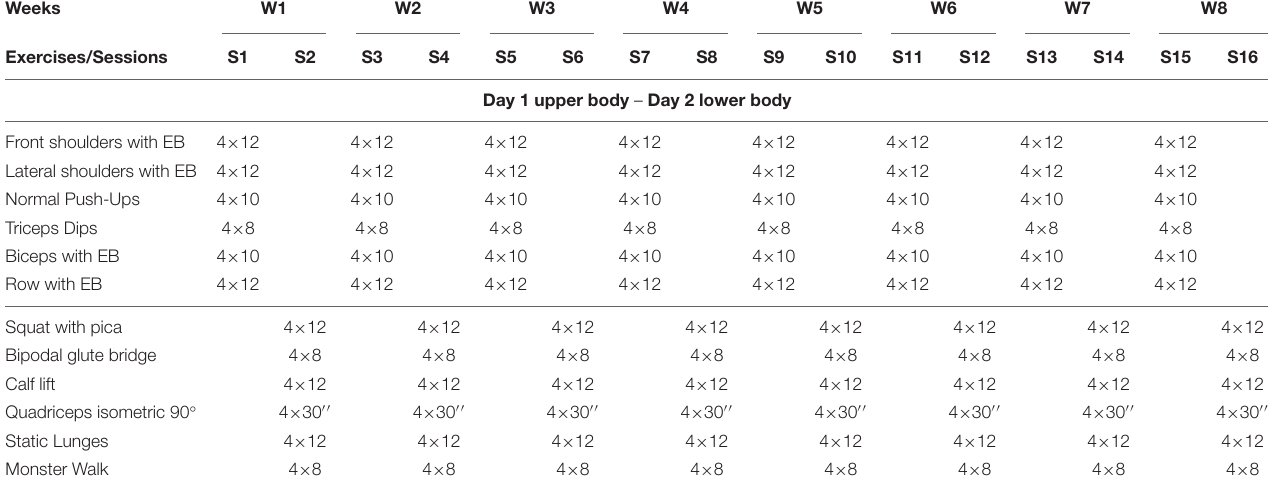
TABLE 1 | Phase 1(A): Self-load treatment.